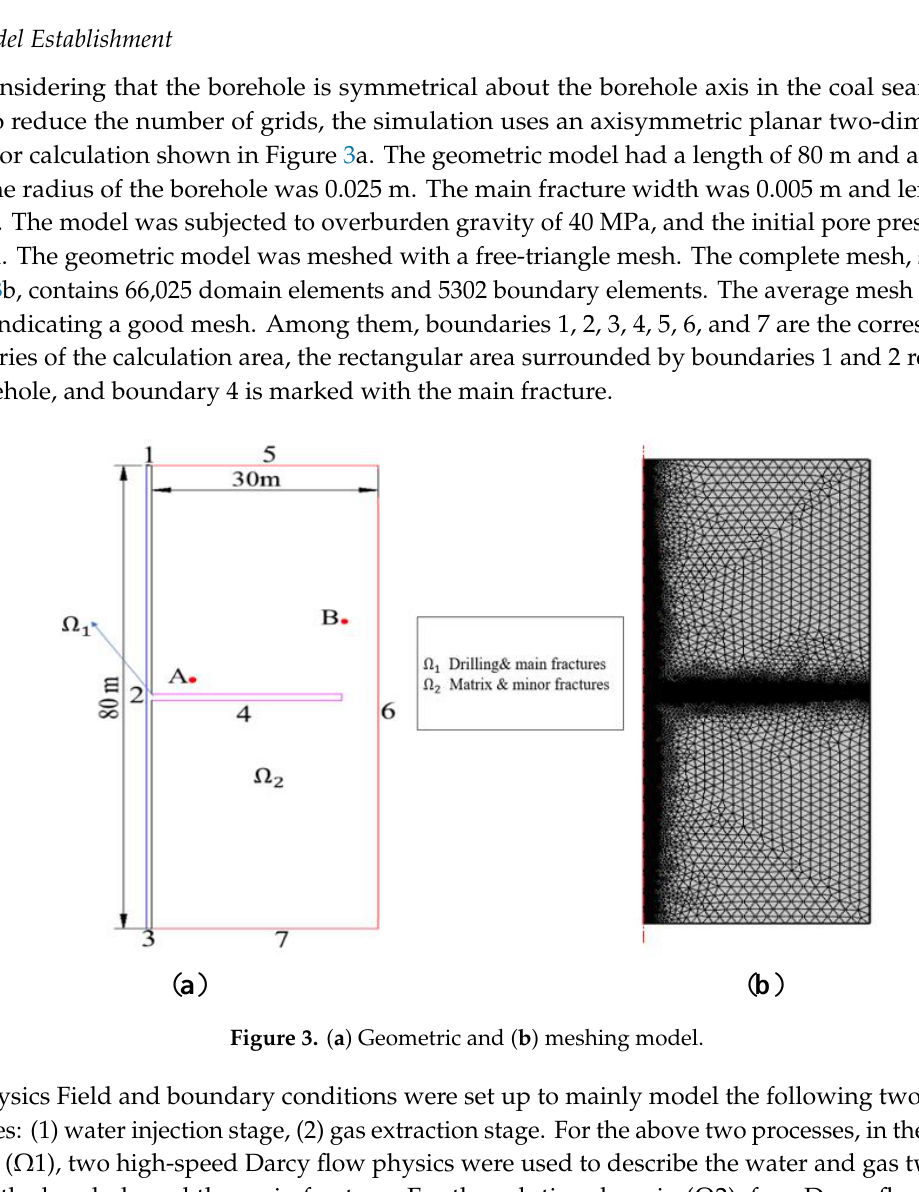
Figure 4. Comprehensive histogram of strata.